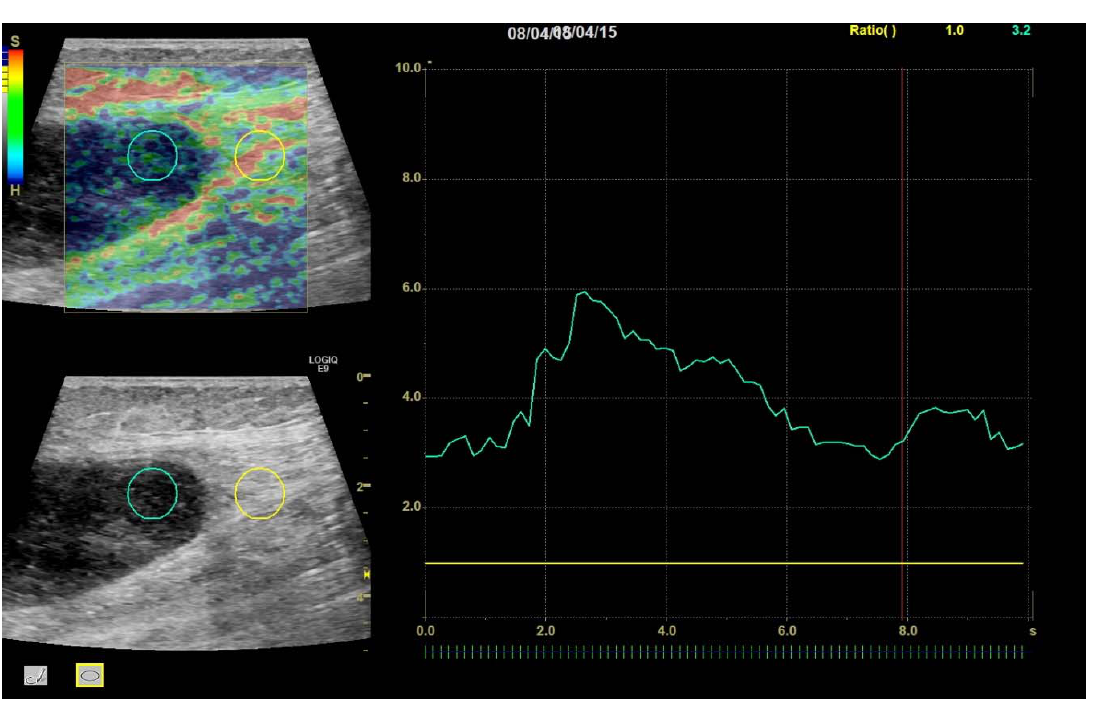
Figure 3. Tsukuba Elasticity Score (TES) scoring system after Itoh et. al. and WFUMB guidelines by Barr et. al. [16,17]. Elastographic patterns corresponding to a higher score are thought to be of higher risk of malignancy.